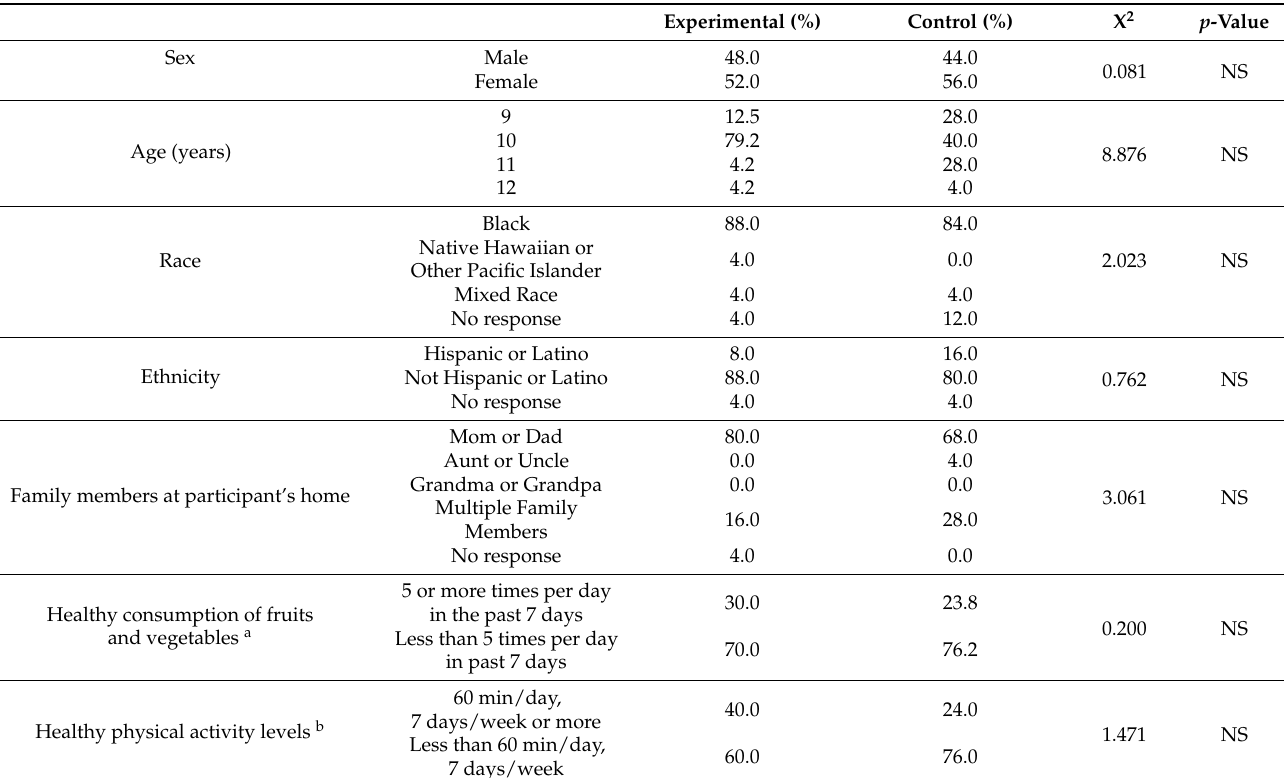
Table 3. Summary of Participant